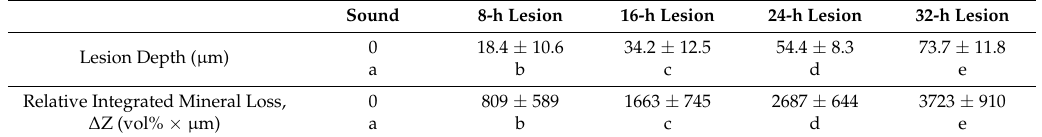
Table 1. Mean ± S.D. for lesion depth and Δ Z from µCT measurements. Groups with the same letters are statistically similar, p > 0.05 in each row (n = 100).